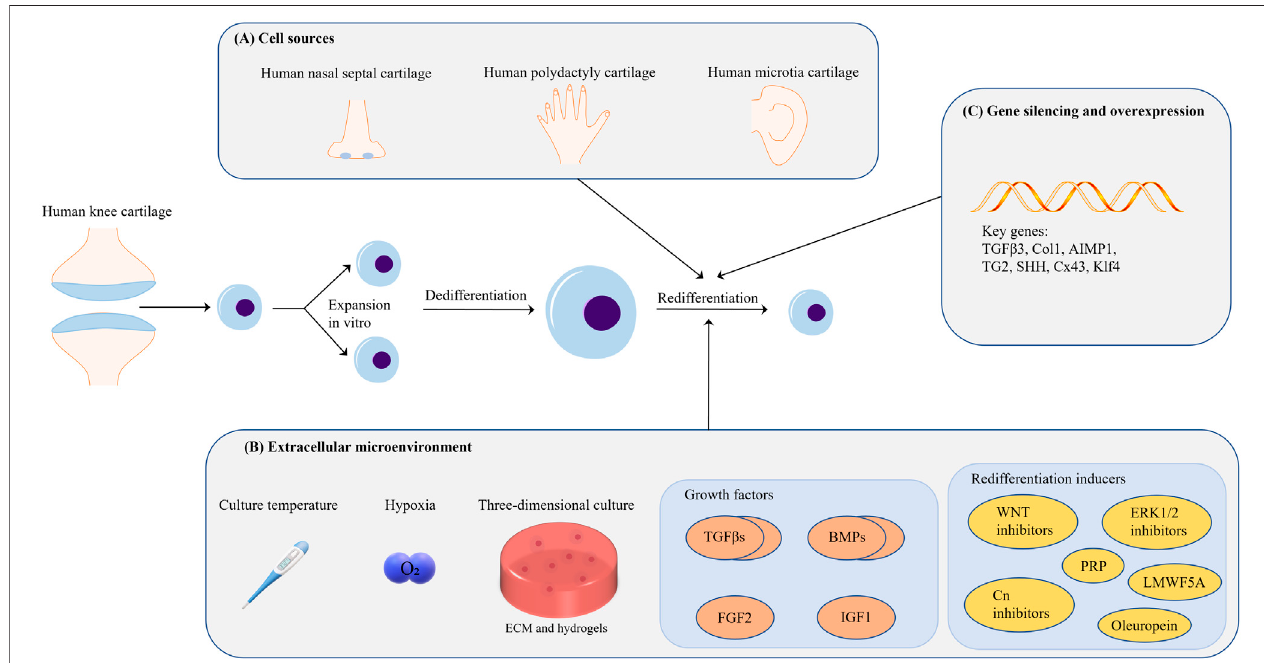
FIGURE 4 | (A) In terms of cell source, it isfeasible to use the cartilage tissue from the patient ’ s own diseased joint as a cell source for ACI; chondrogenic diseases suchaspolydactylyareanotherpotentialcellsource. (B) Manyextracellularenvironmentalfactorsaffectcellredifferentiation;however,properhypoxiaand3Dcultureare bene fi cial for chondrocyte redifferentiation. Hydrogels are the medium used for 3D cell culture, but the related parameter standard of hydrogels warrants further investigation. Members of the TGF- β superfamily are currently the most important chondrocyte redifferentiation inducers. The combined application of growth factors may be a good choice in this context. (C) Research on gene silencing and overexpression for the regulation of chondrocyte redifferentiation is still focused on growth-factor-related genes; thus, additional investigation is needed in this area.